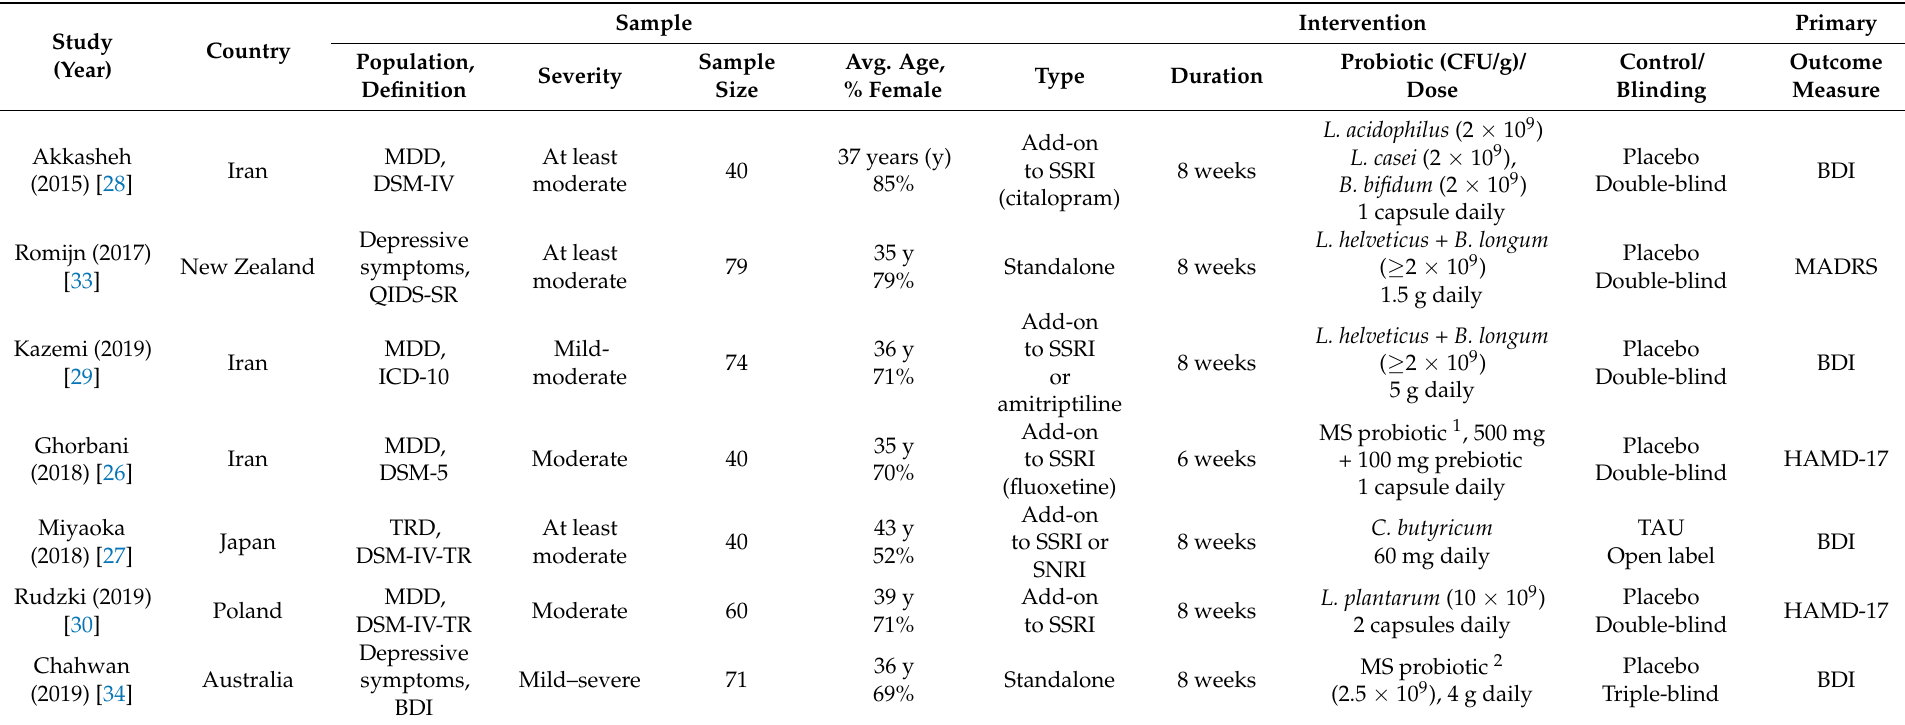
Table 1. Summary of key characteristics of randomised controlled trials (RCTs) of probiotics for clinical depression (in chronological order).